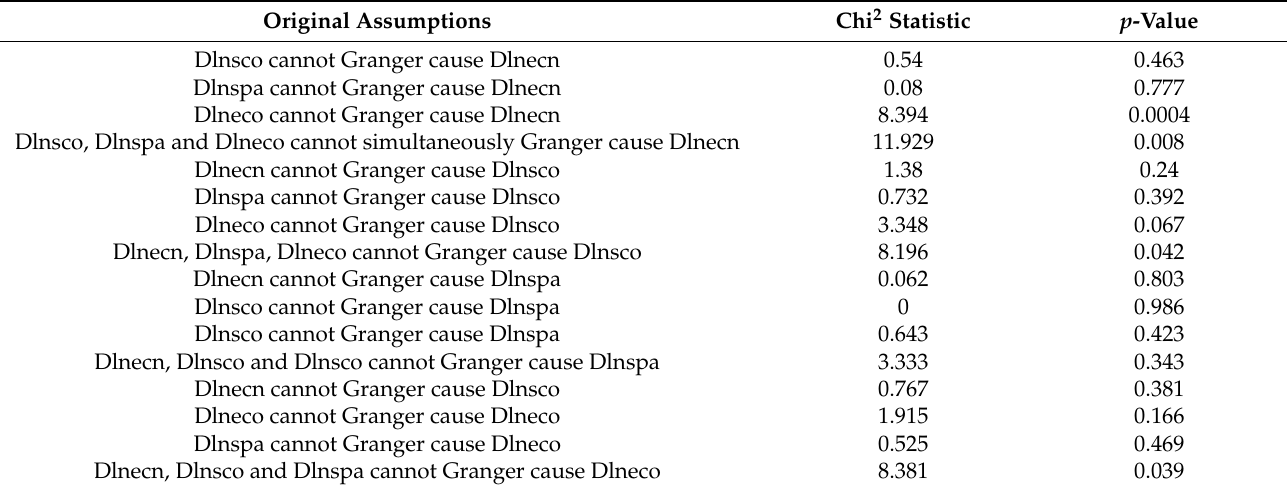
Table 5. Panel Granger causality